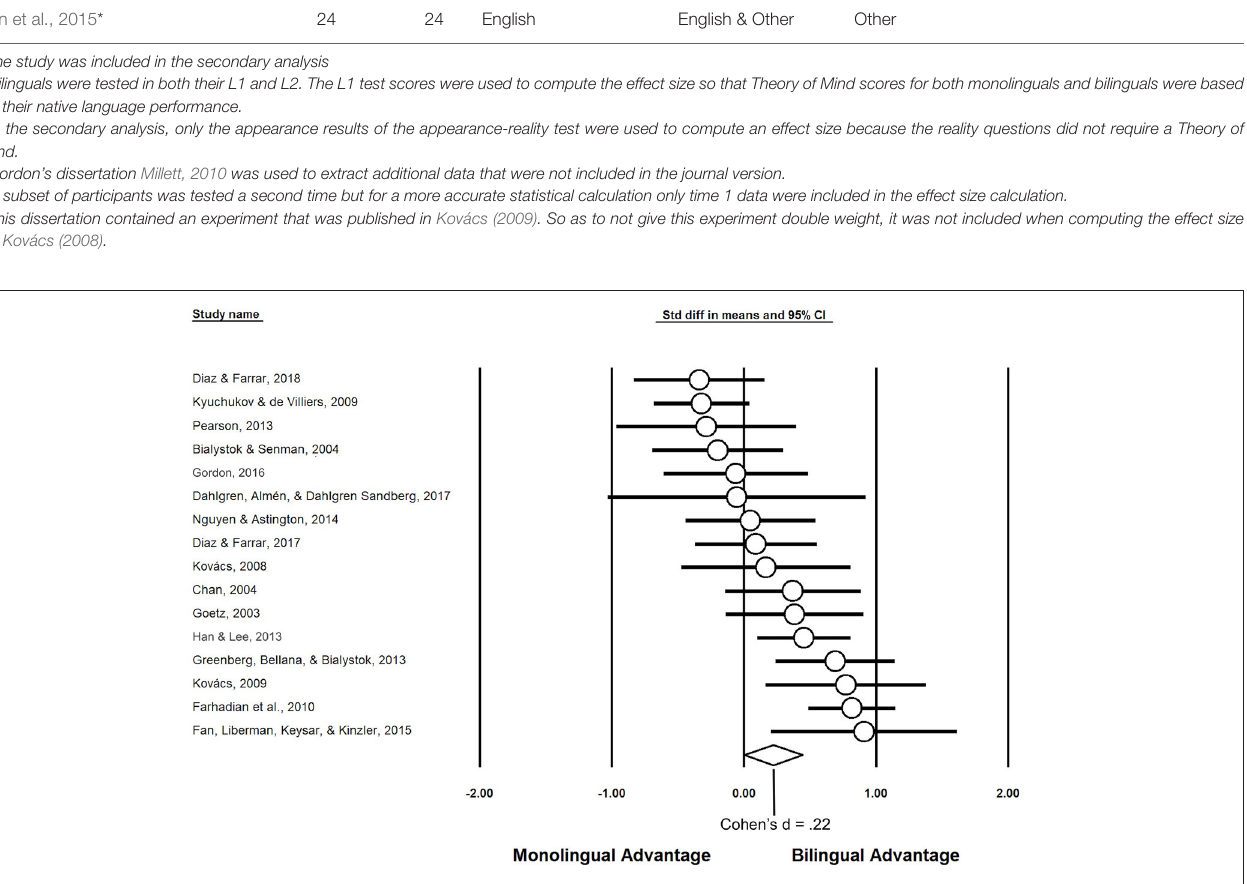
To assess the possibility of publication bias, a funnel plot was generated. See Figure 2 for the plot. There is no apparent asymmetry in the plot, suggestive of no publication